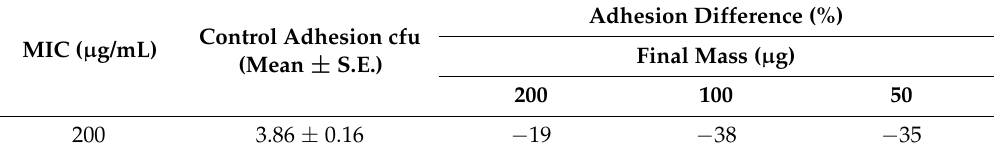
Table 3. Minimum inhibitory concentration (MIC) and reduction in adhesion of Pseudomonas aeruginosa in the presence of 3,4 ′ ,5,7-tetrahydroxy-flavanone from Corymbia torelliana kino. MIC ( µ g/mL)